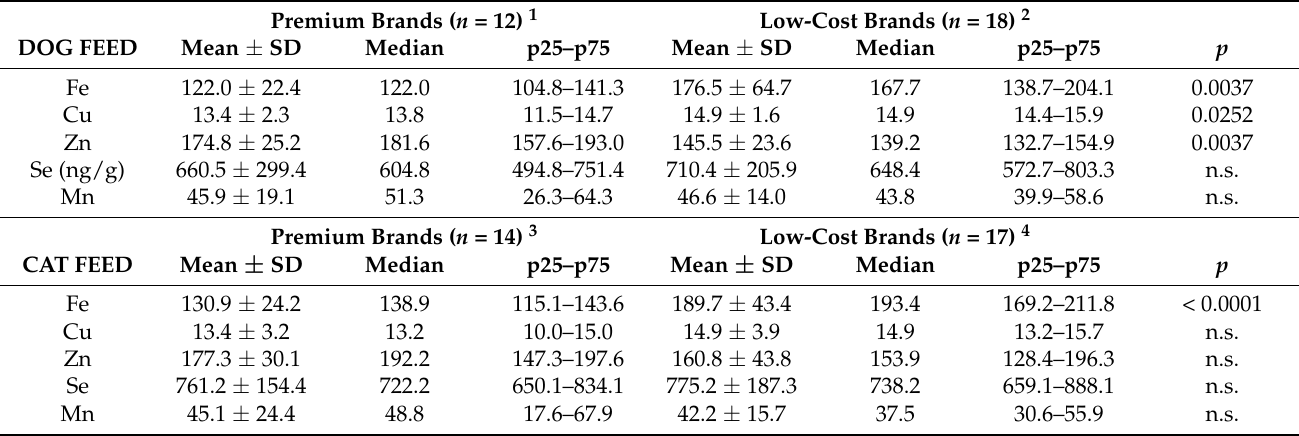
Table 1. Content of essential elements in pelleted dry food for dogs and cats, separated by commercial quality (based on price). Results are expressed in µ g element /g feed